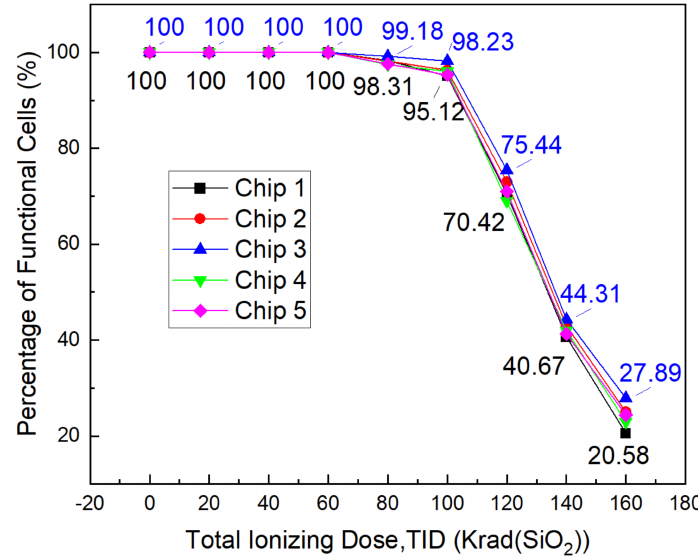
Figure 11. Ratio of functional cells vs. total irradiation dose, 100 Krad(SiO 2 ) is a distinct turning